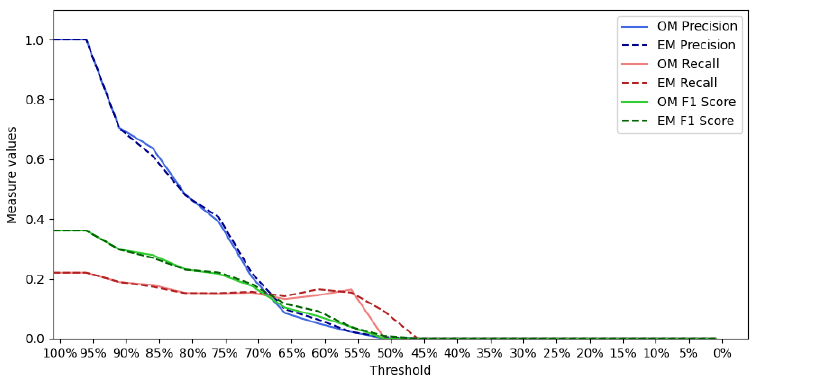
Figure 12. Results of the event “Charlie Hebdo”.